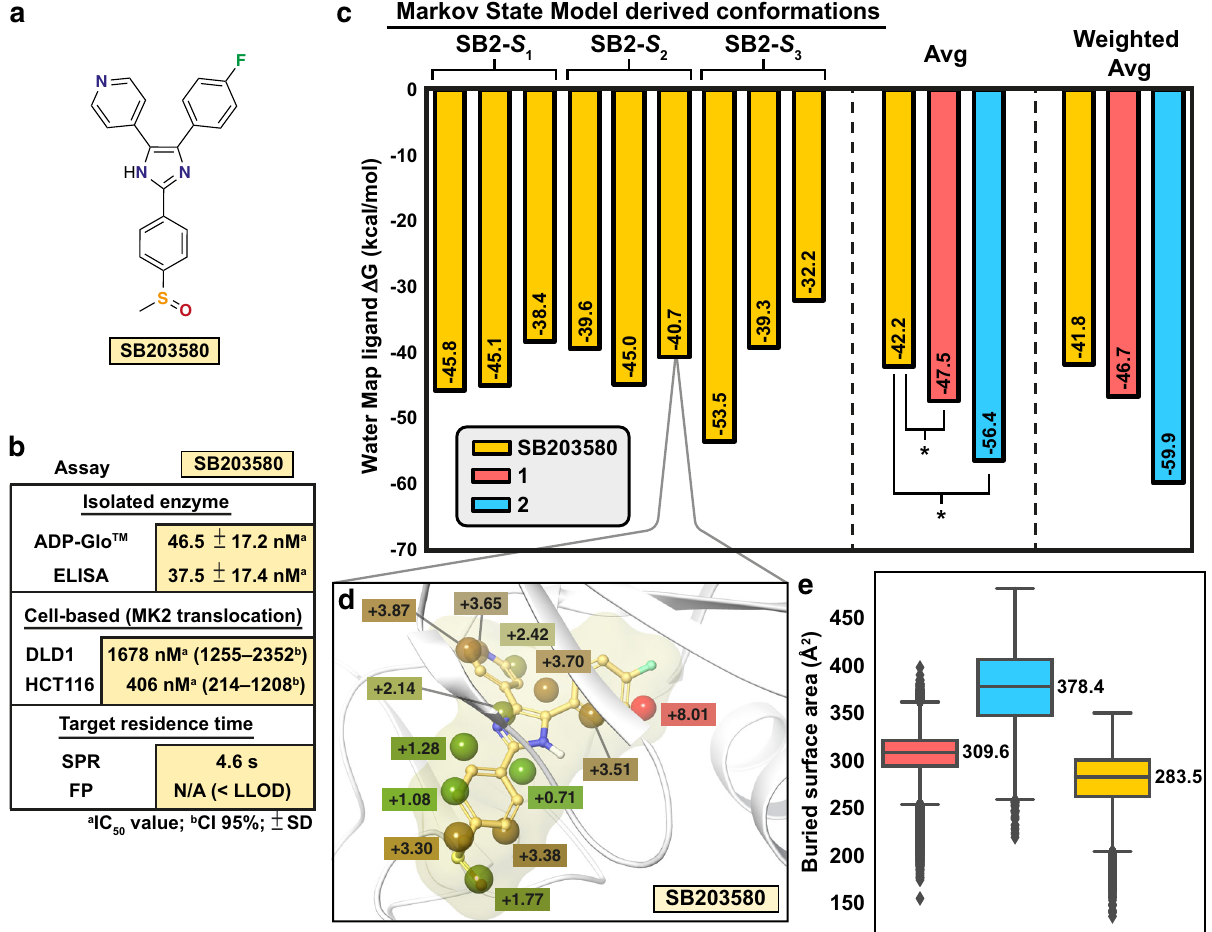
Fig. 7 Short residence time inhibitor SB203580. a Structure of SB203580 is chemically diverse from 1 or 2 . b Biological activity of SB203580 in selected assays. (ADP-Glo, ELISA, DLD1, HCT116, FP: n = 3; SPR n = 2) c WaterMap ligand scores based on the ligand displaced waters in the MSM derived metastable state derived conformations (see Fig. 6 for further details). * P < 0.05 (two-tailed t -test). d Displace d waters by SB203580 in the SB2- S 2 conformation II (hydration sites with overlap factor >0.5 with the ligand are shown). The hydration sites are shown in spheres together with their estimated energies (kcal/mol, Δ G relative to bulk water) and are colored with the green-brown-red scale from low to high energy. SB203580 is shown with ball and stick representation (nonpolar hydrogens are hidden). e Buried surface areas of 1 , 2 and SB203580 . Simulation data was analysed for each 1 ns i.e., data in e consist of 91,328, 86,505, and 91,090 individual data points for 1 , 2 and SB203580 , respectively. The black horizontal line in the box represents the median. Box displays the quartiles of the dataset (25 – 75%) and whiskers the rest of the data with maximum 1.5 IQR. Outliers are indicated with black diamonds. Source data are provided as a Source Data fi